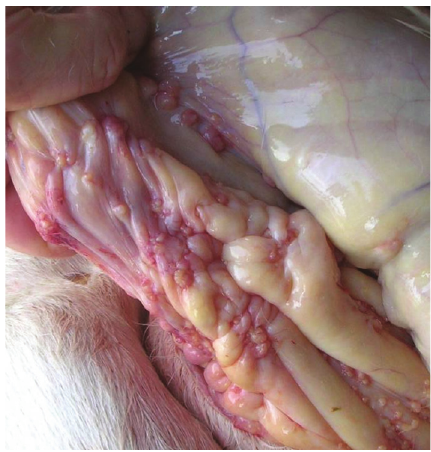
Figure 1: Postmortem examination. Adenocarcinoma metastasis— rosary arranged small size nodules (0.5 to 3 centimetres) in cows’ caudal mesentery.